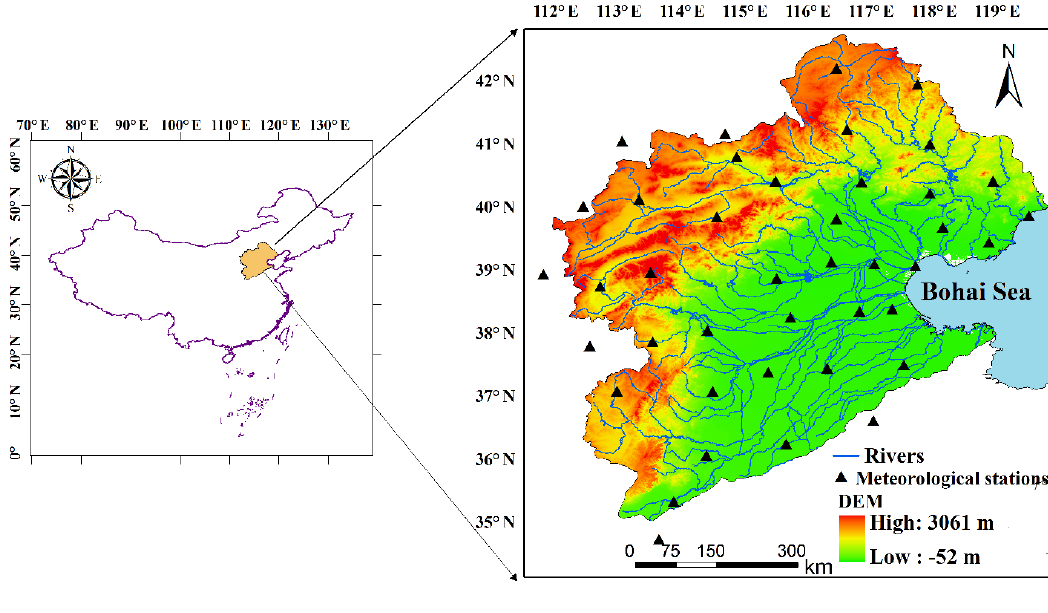
Figure 6. Locations of meteorological stations in the Hai River basin.